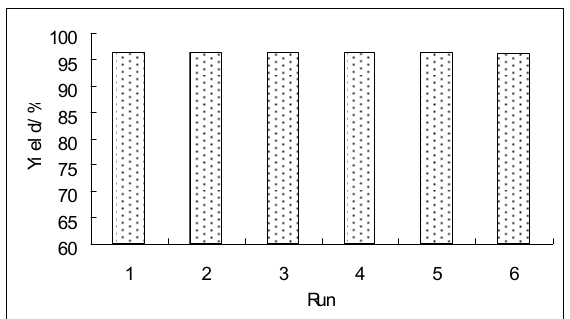
Figure 4. The reuse of the